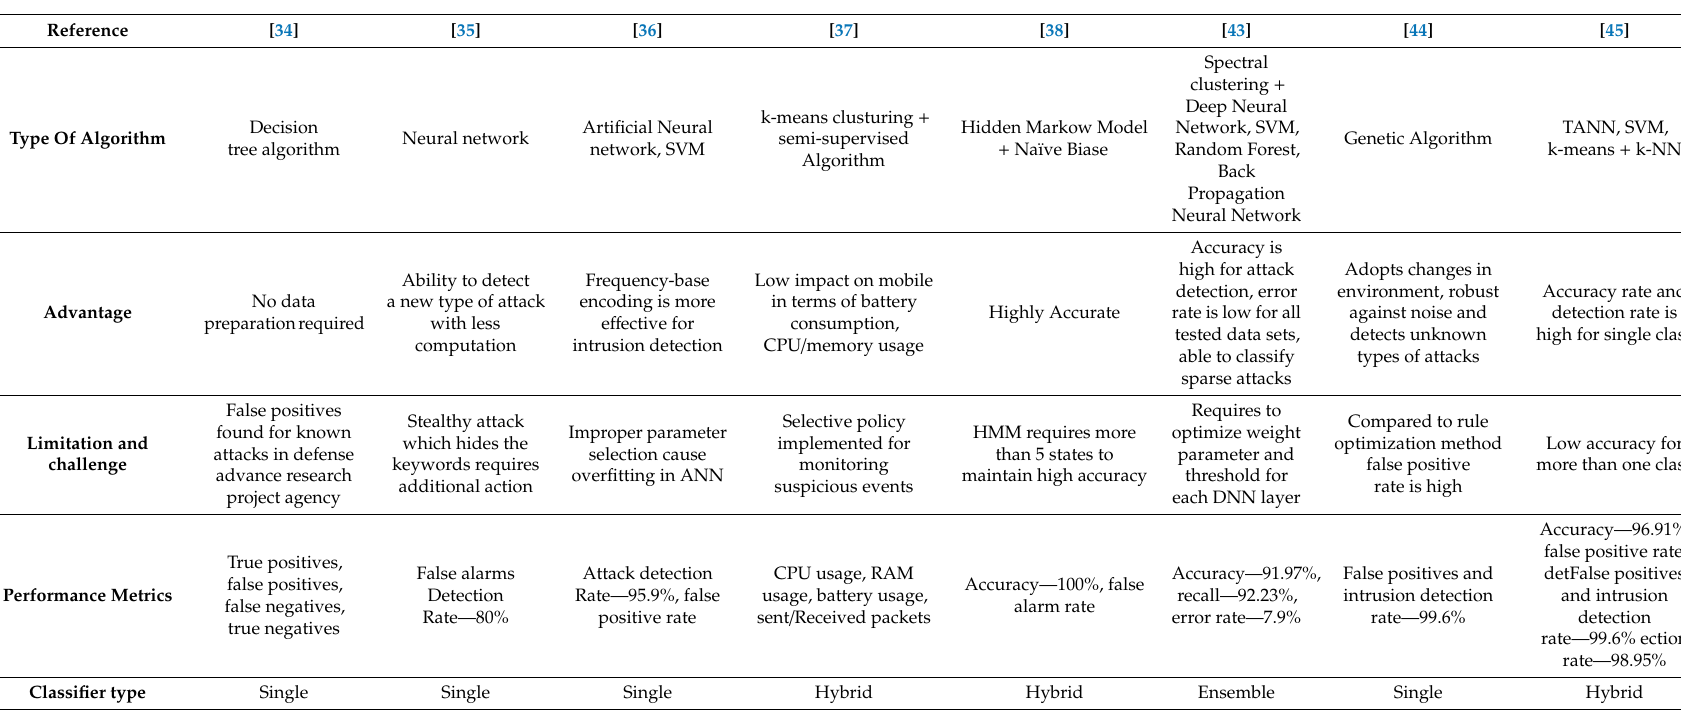
Table 3. Analysis of Signature-based Intrusion Detection Techniques (Notations: SVM-Support Vector Machines, TANN-Triangle Area Based Nearest